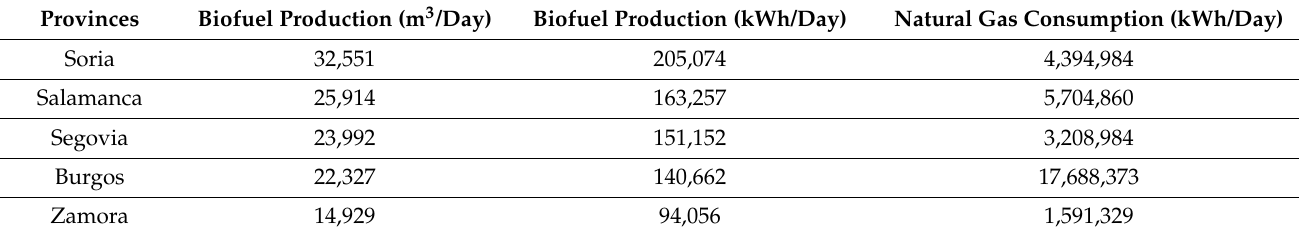
Table 10. Biofuel production and natural gas consumption in each province.